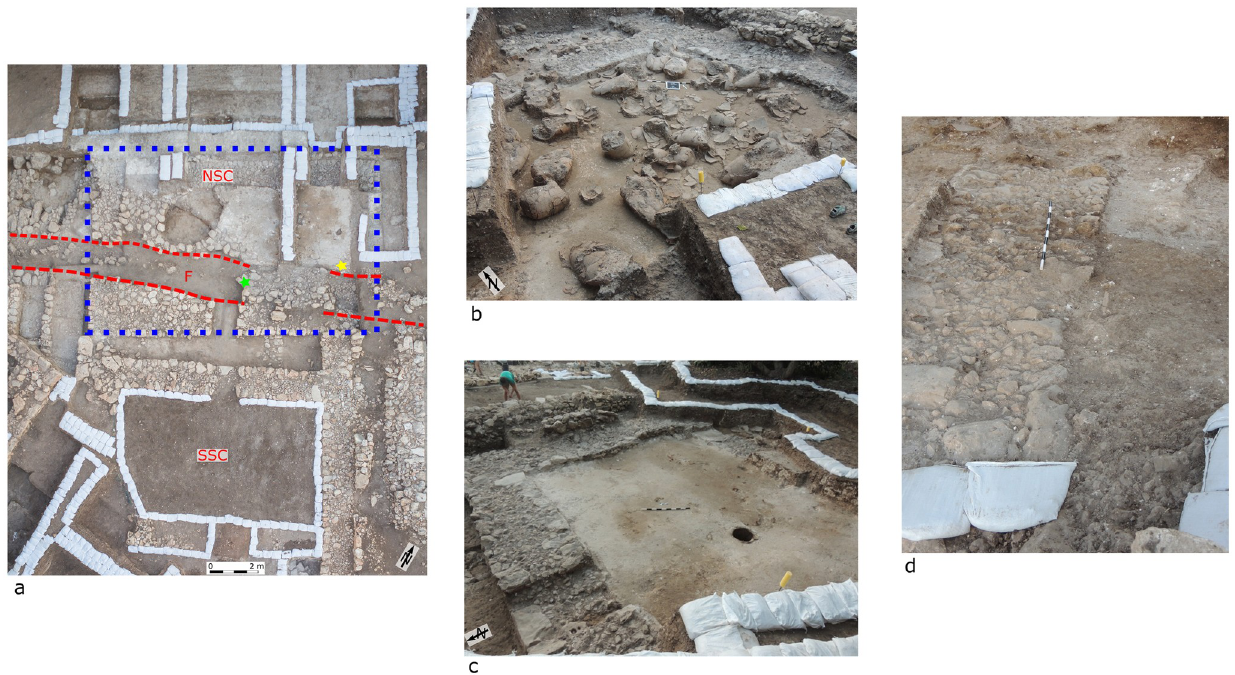
Fig 4. The wine cellar (Room 2440 in the Southern Storage Complex). (a) Aerial view showing the Southern Storage Complex (SSC), the Northern Storage Complex (NSC; blue dashed box) and the Trench (T; also denoted by the dashed red lines). Green star marks the approximate location of Fig 5a. Yellow star marks the approximate location of Fig 5b. Photo: Griffin Aerial Imaging. (b) Room 2440 showing ~48 pithoi found in situ. Note the warping in the eastern wall of the room (W2441 Fig 2). (c) Room 2440 after being cleared of the pithoi. (d) Displaced wall W2443 in Room 2440 marked by blue dashed box on Fig